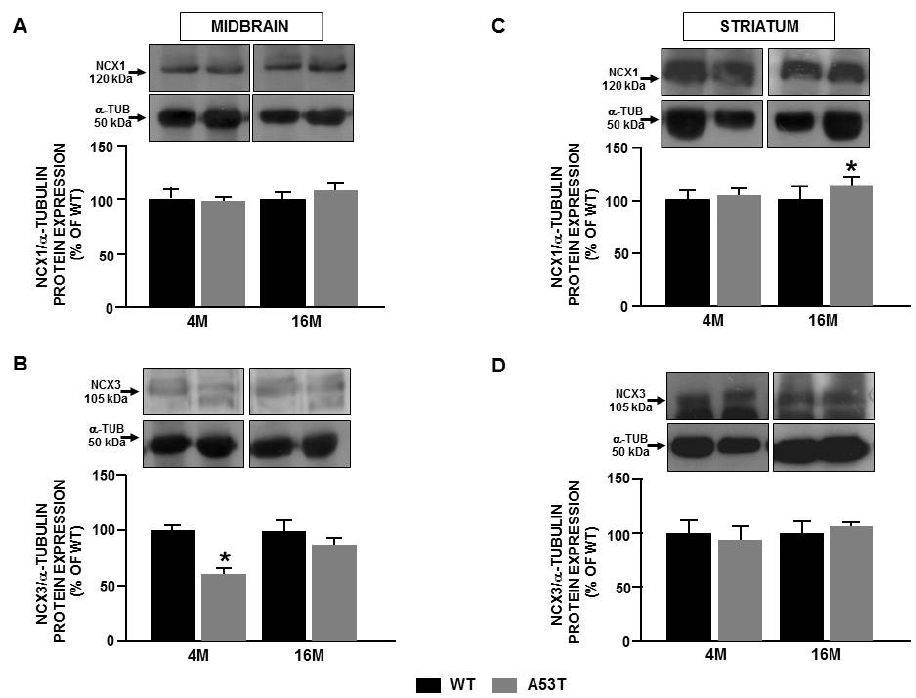
Figure 2. NCX1 and NCX3 expression in midbrain and striatum obtained from 4 and 16-month-old A53T- α -syn and WT mice. Western blot analysis of NCX1 and NCX3 protein expression in midbrain ( A , B ) and striatum ( C , D ) from A53T- α - syn and WT mice. Each bar represents the mean ± S.E.M. of the percentage of different experimental values obtained in three independent experimental sessions. * p < 0.05 compared to WT mice at the same age.